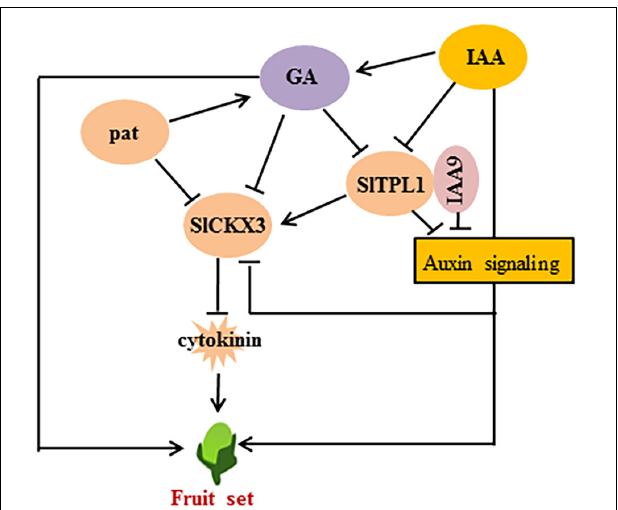
FIGURE 9 | Hypothetical model showing the concerted action of S1TPL1 and SIIAA9 in the regulation of fruit set by modulating cytokinin metabolite related gene